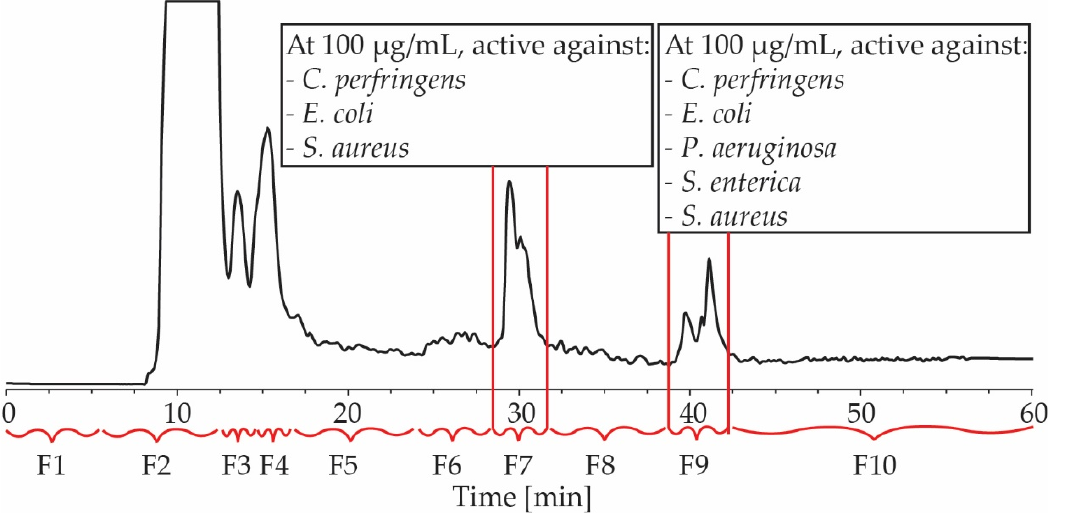
Figure 2. An HPLC chromatogram of BPR-17 EtOAc extract at 214 nm. Indicated are fractions 1–10